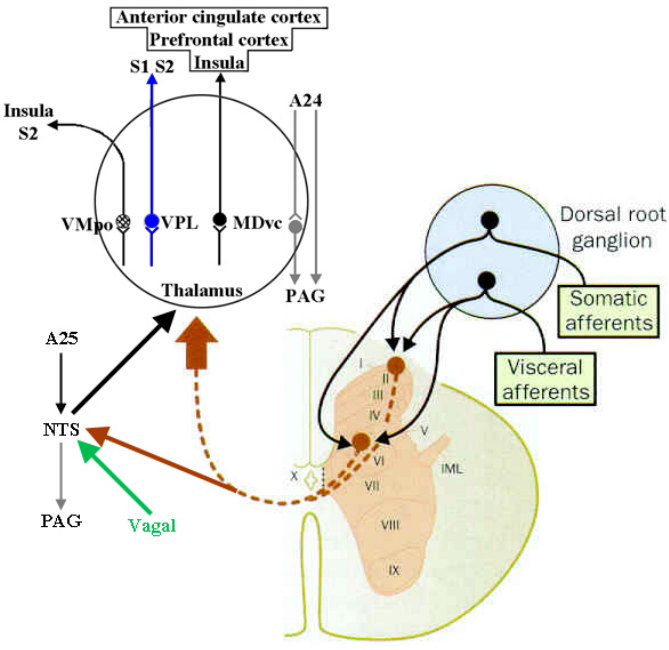
FIGURE 4 . Viscerosomatic convergence of primary afferent fibers on neurons of lamina I and V of the spinal dorsal horn. Supraspinal and vagal projections to the NTS and thalamus are shown with subsequent projection to cortical structures and descending projection to the PAG. Adapted from Janig[14], Cervero[12], and Derbyshire[18]. See text for further details. IML = interomedial cell column; MDvc = ventral caudal part of the medial dorsal nucleus; VPL = ventral posterior lateral nucleus; VMpo = posterior part of the ventral medial nucleus; S1 = primary somatosensory cortex; S2 = secondary somatosensory cortex; PAG = periaquaductal gray; NTS = nucleus tract